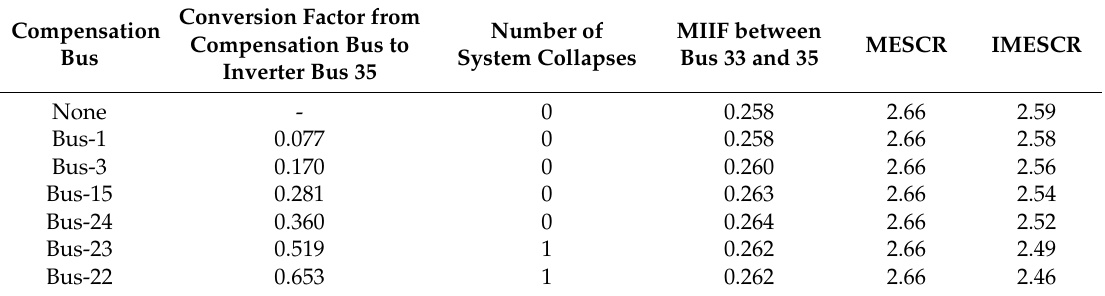
Table 3. MESCR and IMESCR of the DC inverter bus-35 under different compensation buses. Compensation